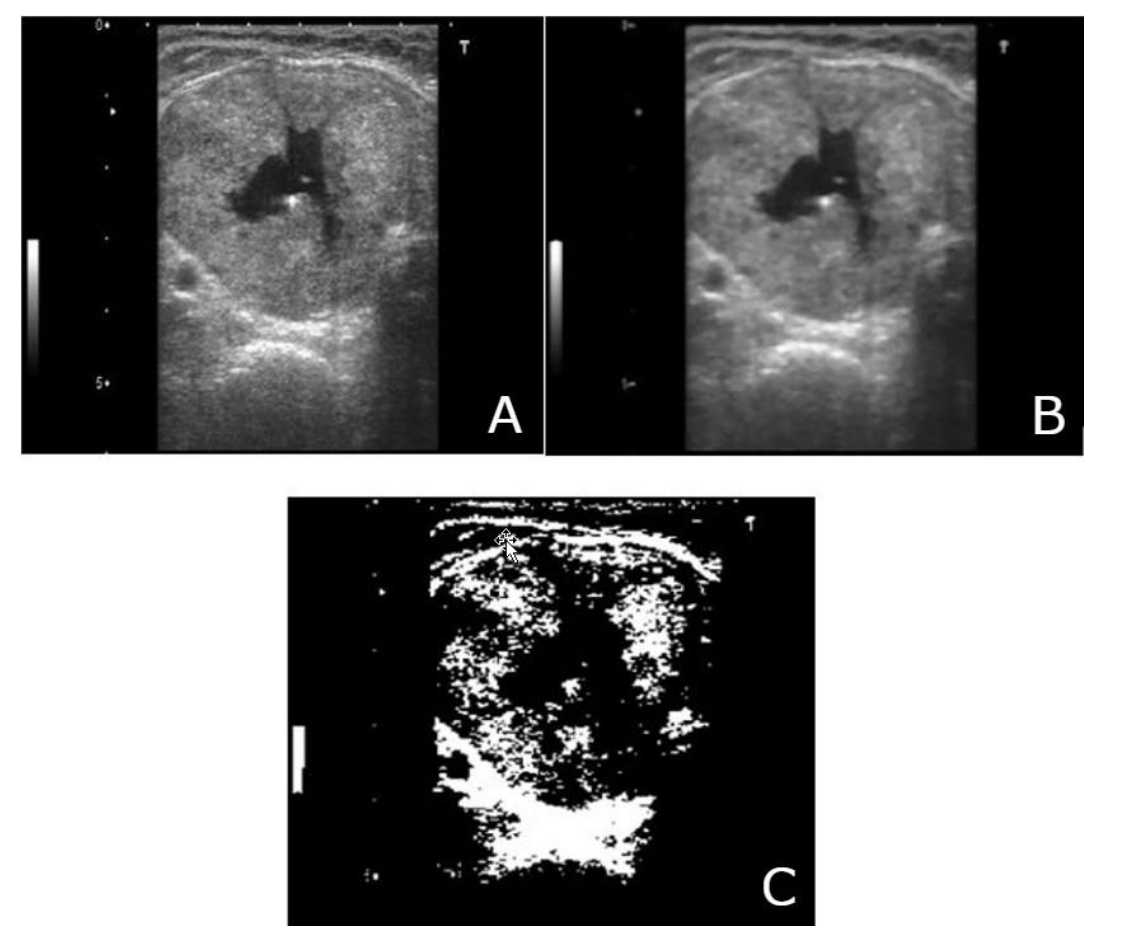
Figure 10. ( A ) Original image (benign)-Top Left; ( B ) median filtered image (benign)-Top Right; ( C ) segmentation-Center Bottom. Table 2. Performance metric of ANN and SVM test phase.